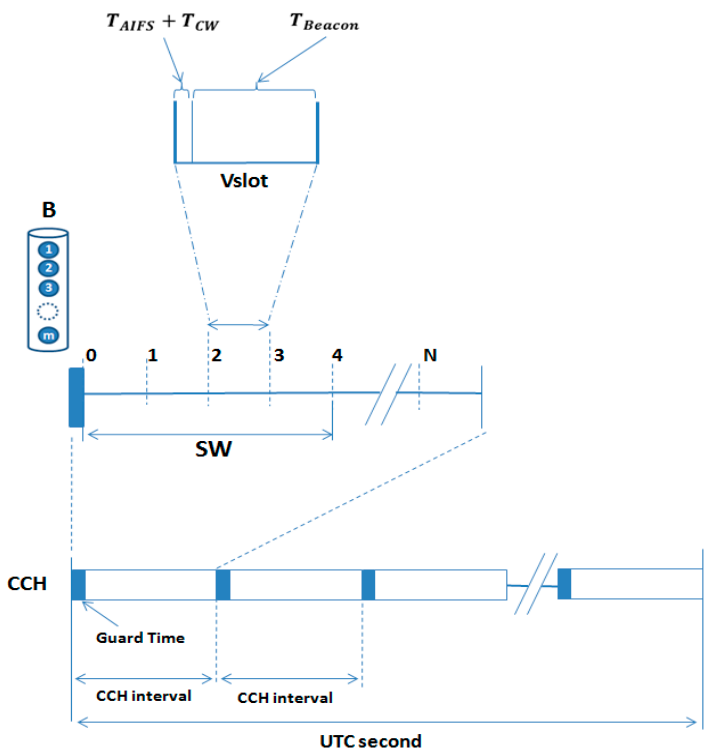
Figure 1. Virtual time slicing and SW size, compared to the CCH interval.